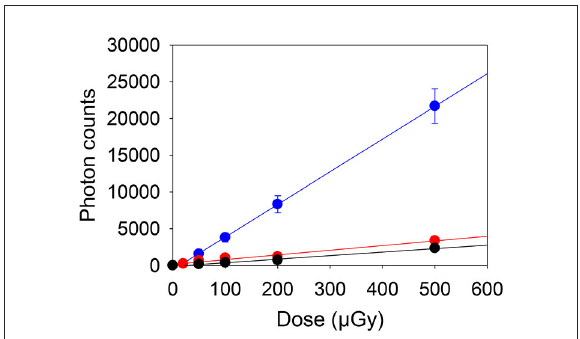
FIGURE1 Dose response from gamma irradiated samples measured using a blue OSL portable reader (blue), 890nm IRSL (red) and the pulsed PSL (black) instruments, after subtraction of the signals from the salt which did not receive additional